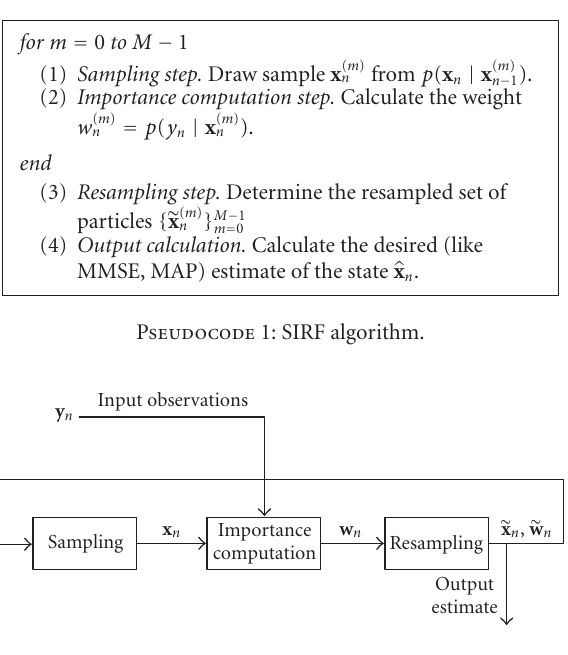
Figure 1: Overall structure of the